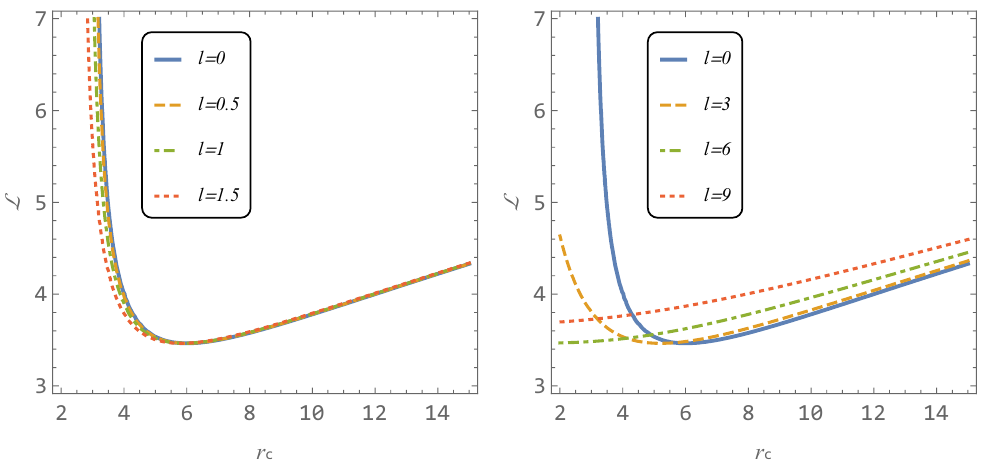
Figure 3. The radial profiles of the specific angular momentum L of test particle for characteristic values of the parameter l and M = 1. Values of l giving regular black holes are on the left panel, while values of l giving wormholes (except l = 0 giving the Schwarzschild black hole) are on the right